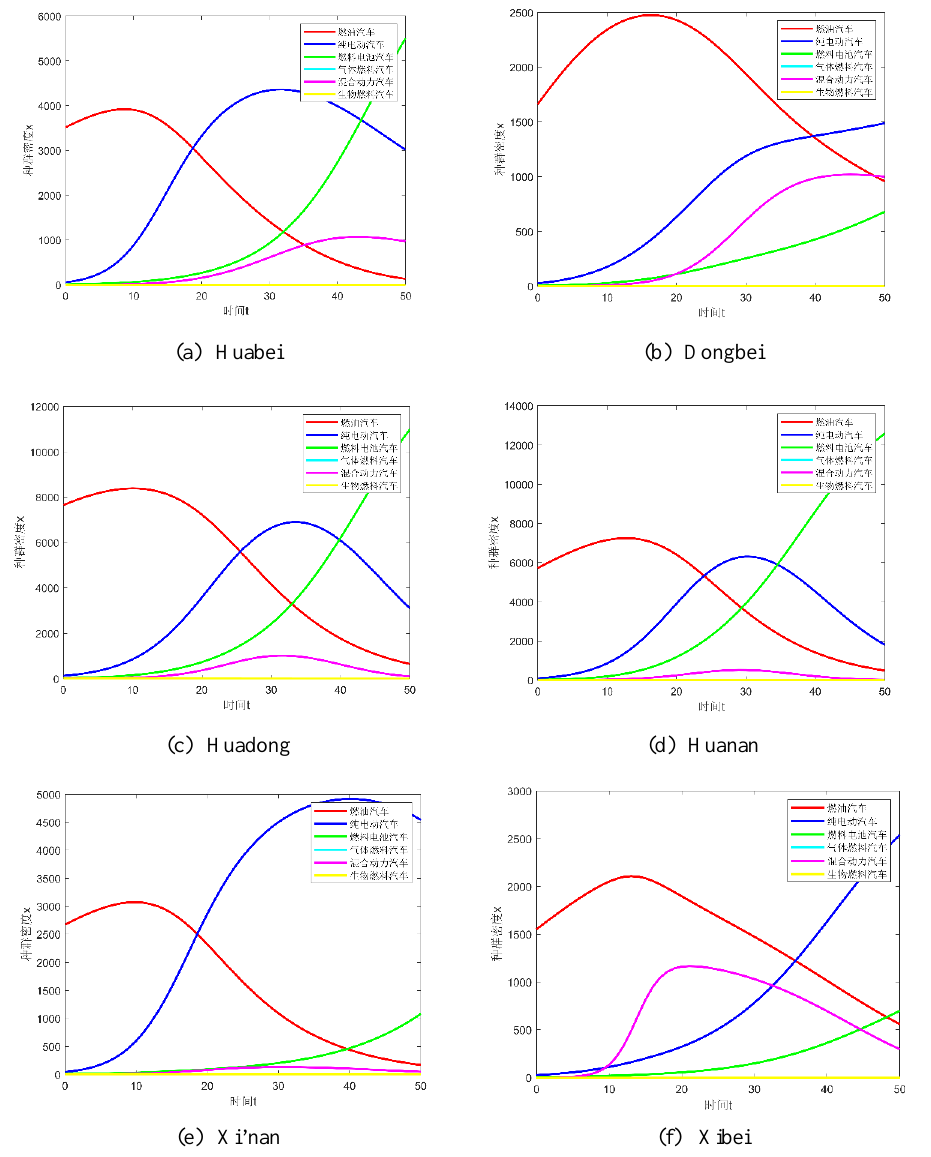
Fig. 1 Different energy sources vehicle ownership